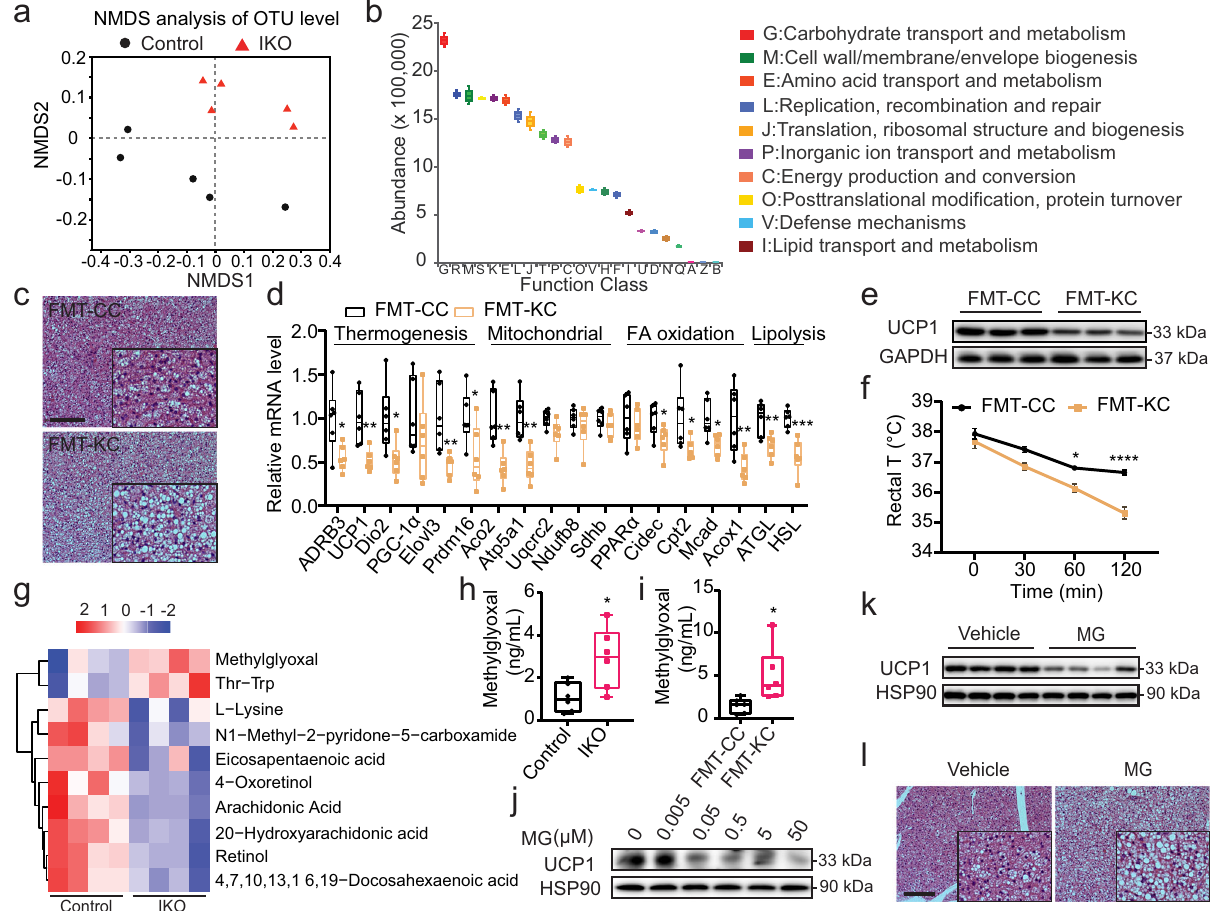
Fig. 2 Intestinal AMPK remotely regulates BAT function by modulating gut microbiota and their metabolites. a Non-metric multidimensional scaling (NMDS) analysis of operational taxonomic unit (OTU) levels in AMPK α 1 fl / fl (Control) and AMPK α 1-IKO mice fed chow diet ( n = 5 biologically independent samples). b Functional classi fi cation of microbiota with differential abundance in AMPK α 1-IKO mice compared to AMPK α 1 fl / fl mice, based on the Clusters of Orthologous Groups (COGs) database ( n = 5 biologically independent samples). c Representative images of H&E-stained BAT sections from FMT recipient mice. Scale bar = 100 µ m. FMT-CC, FMT from AMPK α 1 fl / fl mice to WT mice; FMT-KC, FMT from AMPK α 1-IKO mice to WT mice. d Relative mRNA levels of genes expressed in the BAT of recipient mice ( n = 6 biologically independent samples). P value: 0.0171, 0.0041, 0.0203, 0.0097, 0.0380, 0.0025, 0.0018, 0.0357, 0.0371, 0.0121, 0.0080, 0.0080, 0.0007. e Representative Western blot analysis of UCP1 protein levels in the BAT of